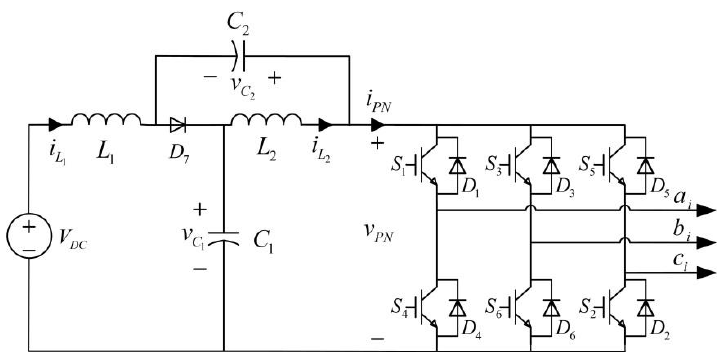
Figure 1. Single module topology of the line voltage cascaded quasi-Z-source inverter (LVC-qZSI). C , C , L , and L are the Z-source network capacitances and inductances, In Figure 1, 1 2 1 2 S to S represent six IGBTs, and D to D represent six freewheeling diodes. The the DC diode, 1 6 1 6 small signal model is established in a switching period, as shown in Formula (1).